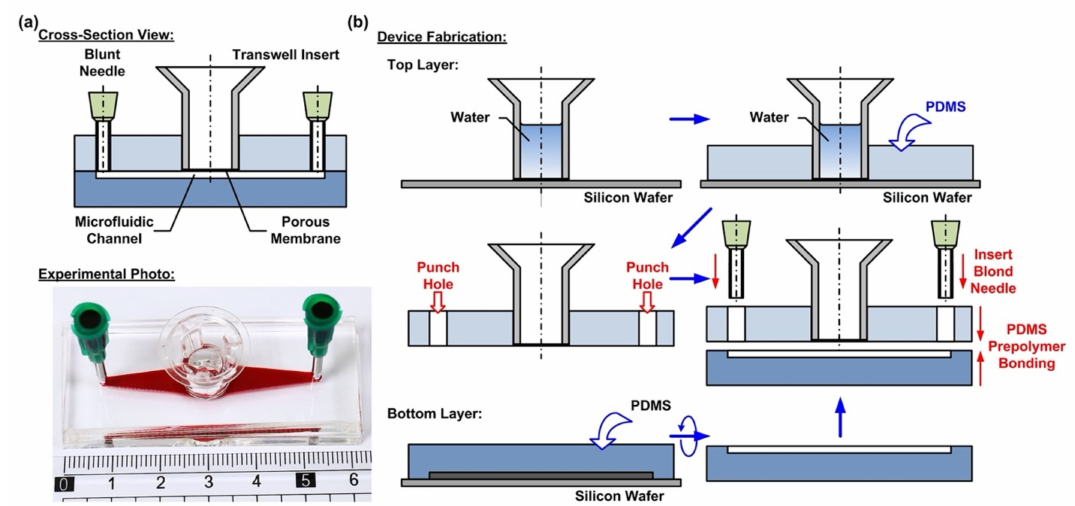
Figure 1. ( a ) Cross-sectional view and the experimental photo of the transwell insert-embedded microfluidic device capable of culturing cells at the air–liquid interface (ALI), mimicking alveolar epithelium. ( b ) Fabrication process of the transwell insert-embedded microfluidic device based on the soft lithography